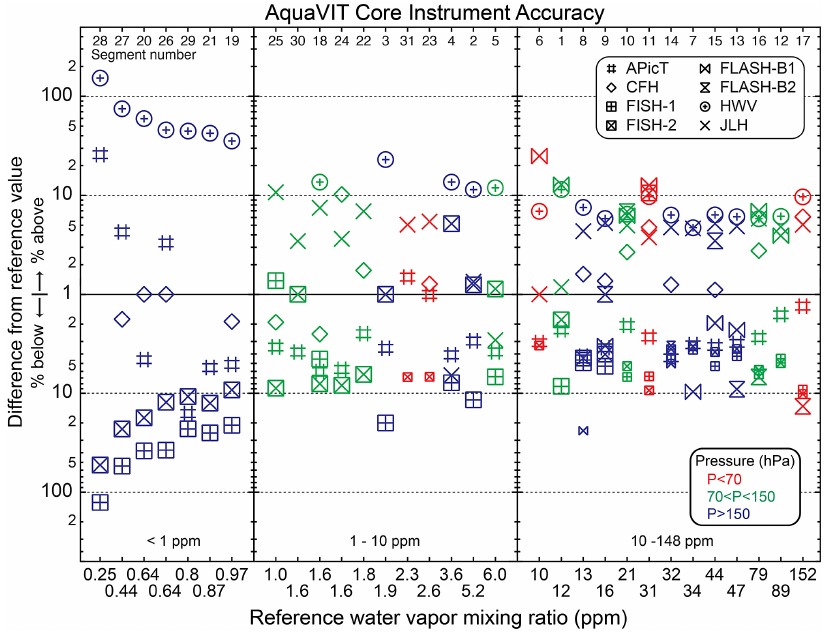
Figure 7. Summary plot of static experiment results for core instruments shown as the percent difference between values from the listed instruments and the corresponding reference values for three ranges of the reference values. Data from the FLASH instruments are not included in the reference value (see text). A symbol represents the result for the segment number noted near the top axis. The use of a small symbol size for a segment indicates that the accuracy and precision cannot be defined based on the relationships in Table 3. Segment details are provided in Table 4. Colors represent the AIDA chamber average pressure during the segment. Differences less than or equal to 1% are plotted as a 1%